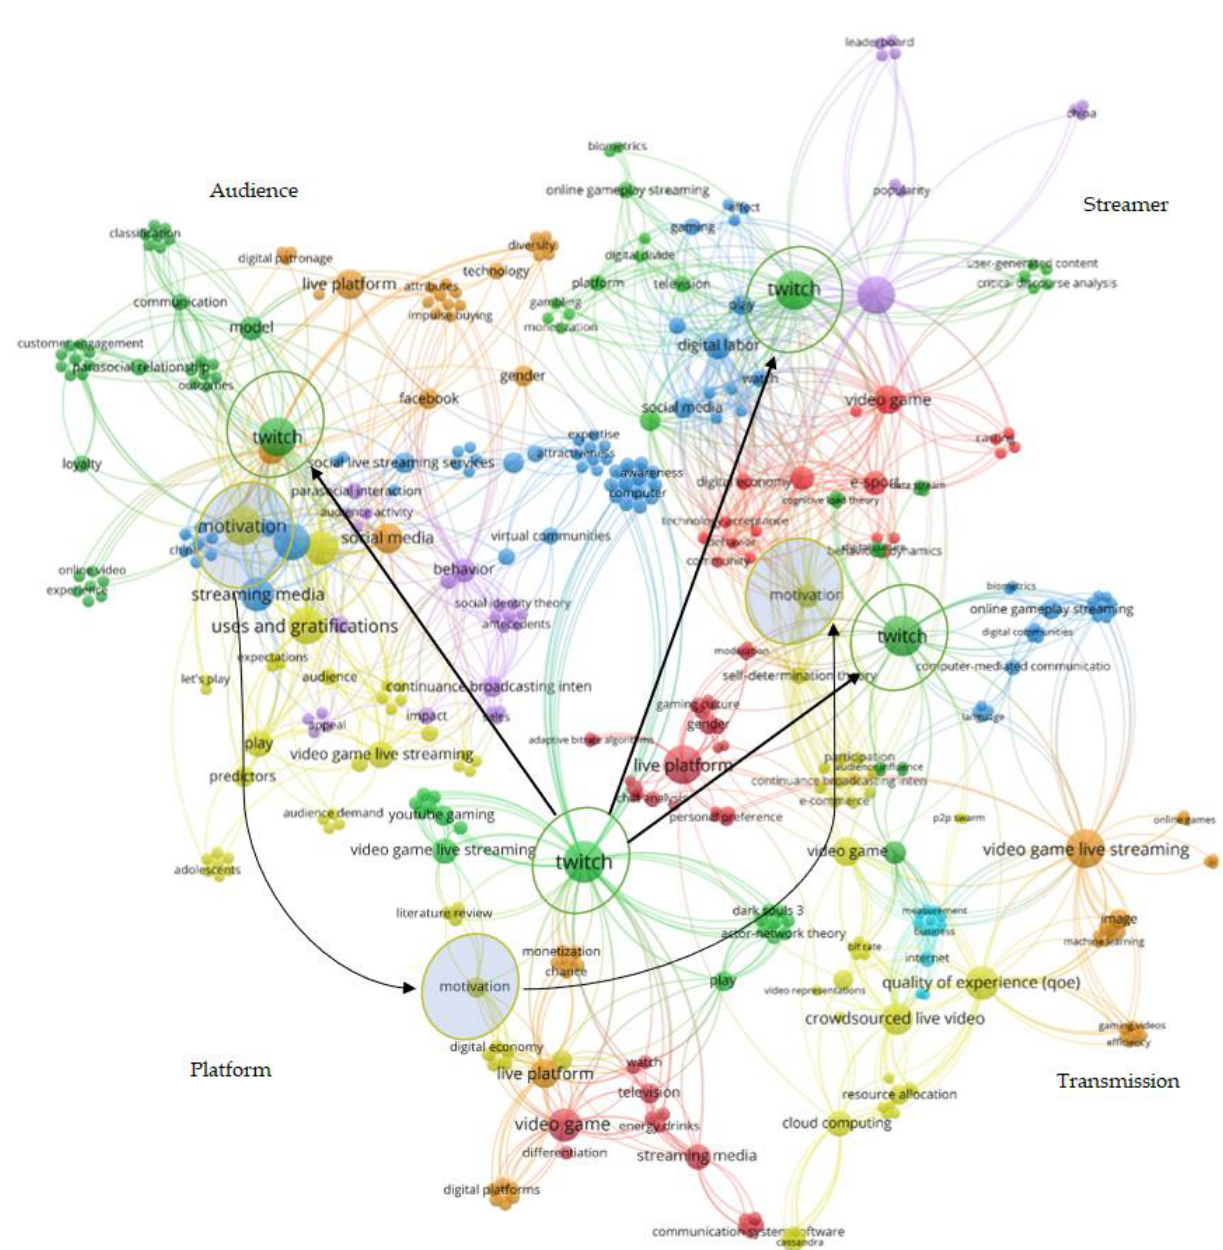
Figure 5. Connections between the different subdomains identified in the sample of documents.